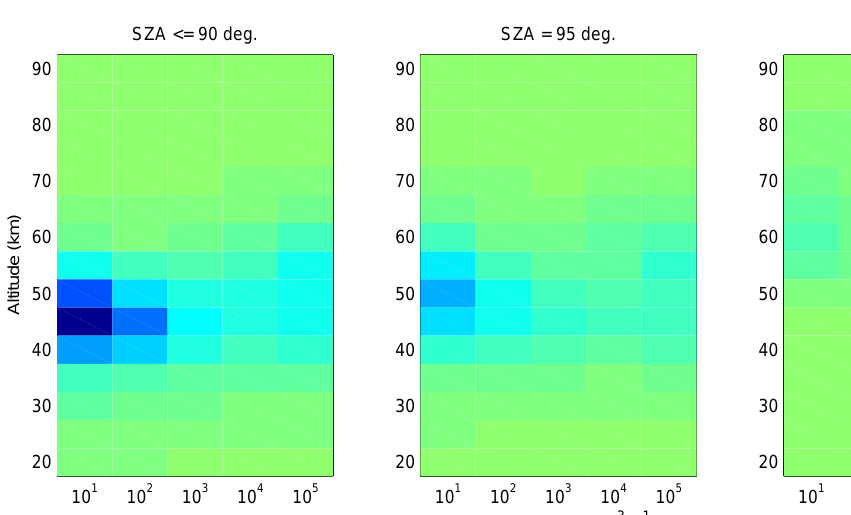
Fig. A13. P NO /Q for January